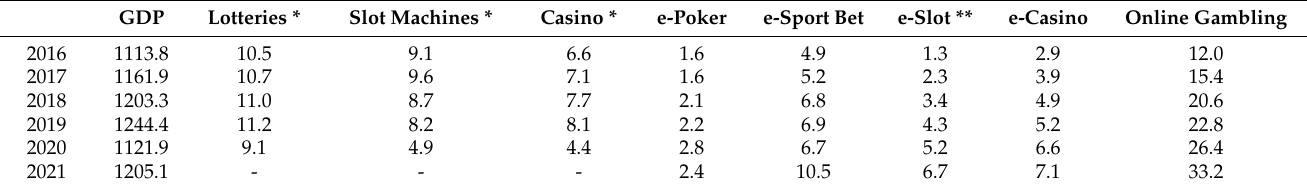
* No official data for spending on offline gambling are available as yet. ** Online slot gambling was legalized in July 2015.